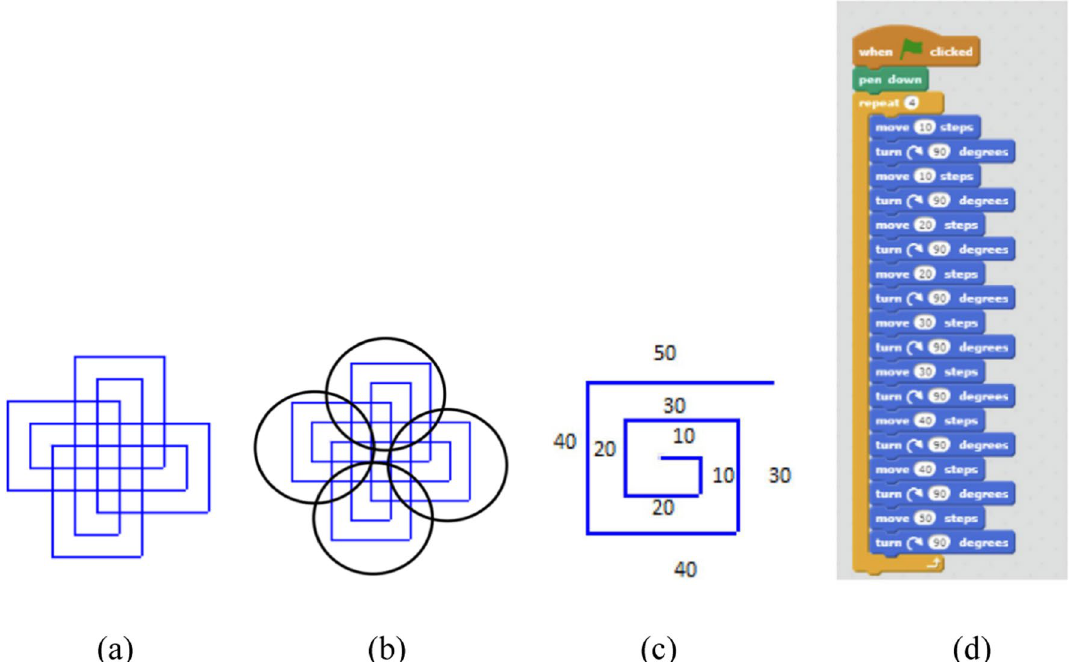
Fig. 7 a Spirolateral shown to students, b , c students’ conceived structure of the spirolateral, and d sample Scratch codes (Miller, 2019, pp.